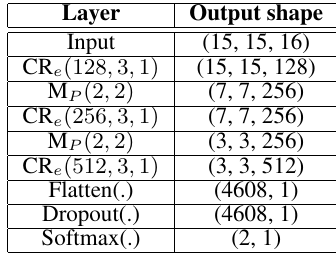
Table 4. EF classifier